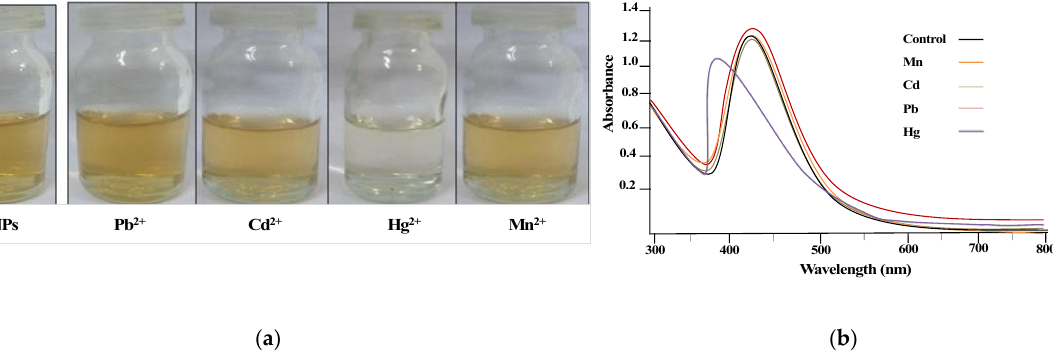
Figure 5. Visual response ( a ) and UV – Vis spectra ( b ) of different metal ion interactions with AgNPs@AA.